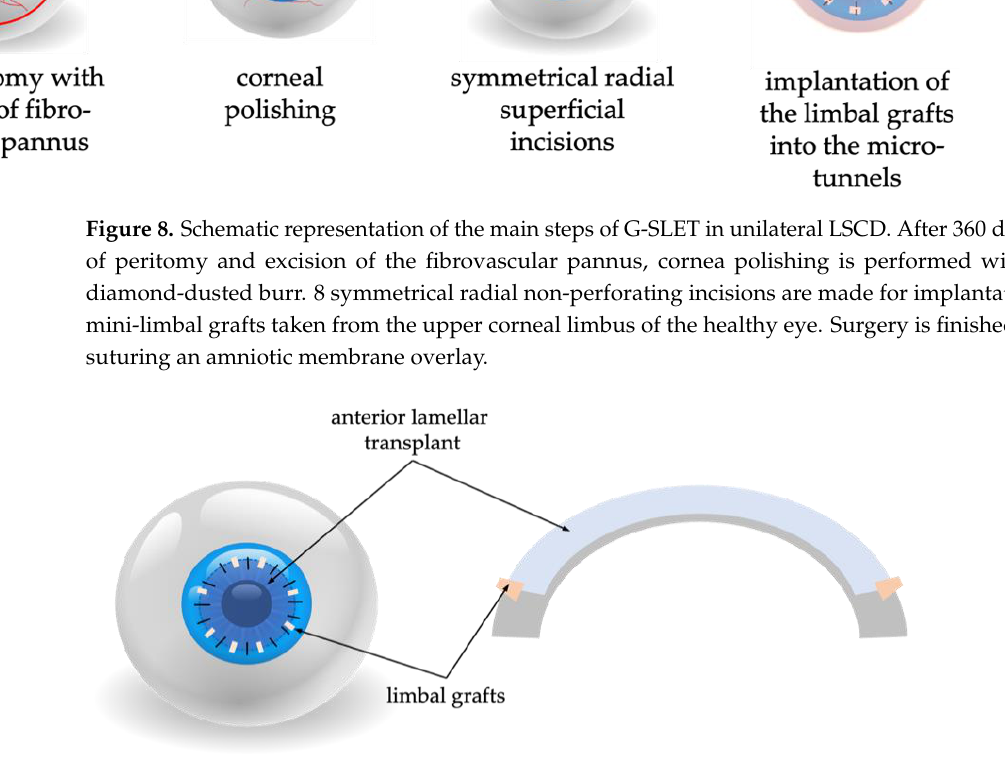
Figure 9. Schematic representation of the main steps of simultaneous anterior lamellar keratoplasty (ALK) and G-SLET in patients with thin corneas. After 360 degrees peritomy ALK is performed. Single sutures (10-0 nylon) are used for donor corneal transplant fixation. Limbal mini-grafts are placed in the donor-recipient interface.